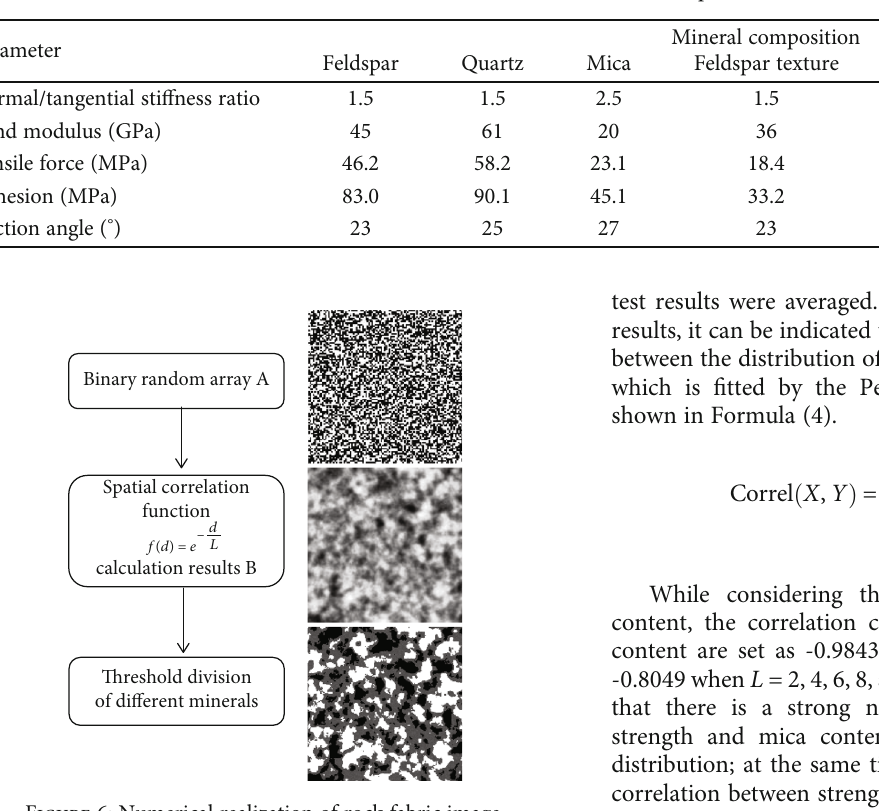
Table 2: Contact micromechanical parameters.